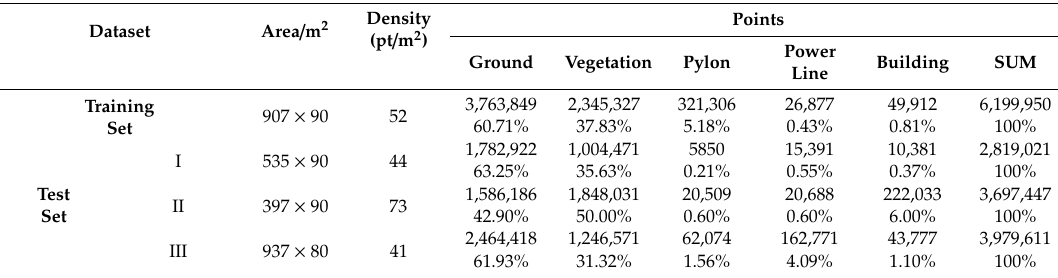
Table 2. Overview of the